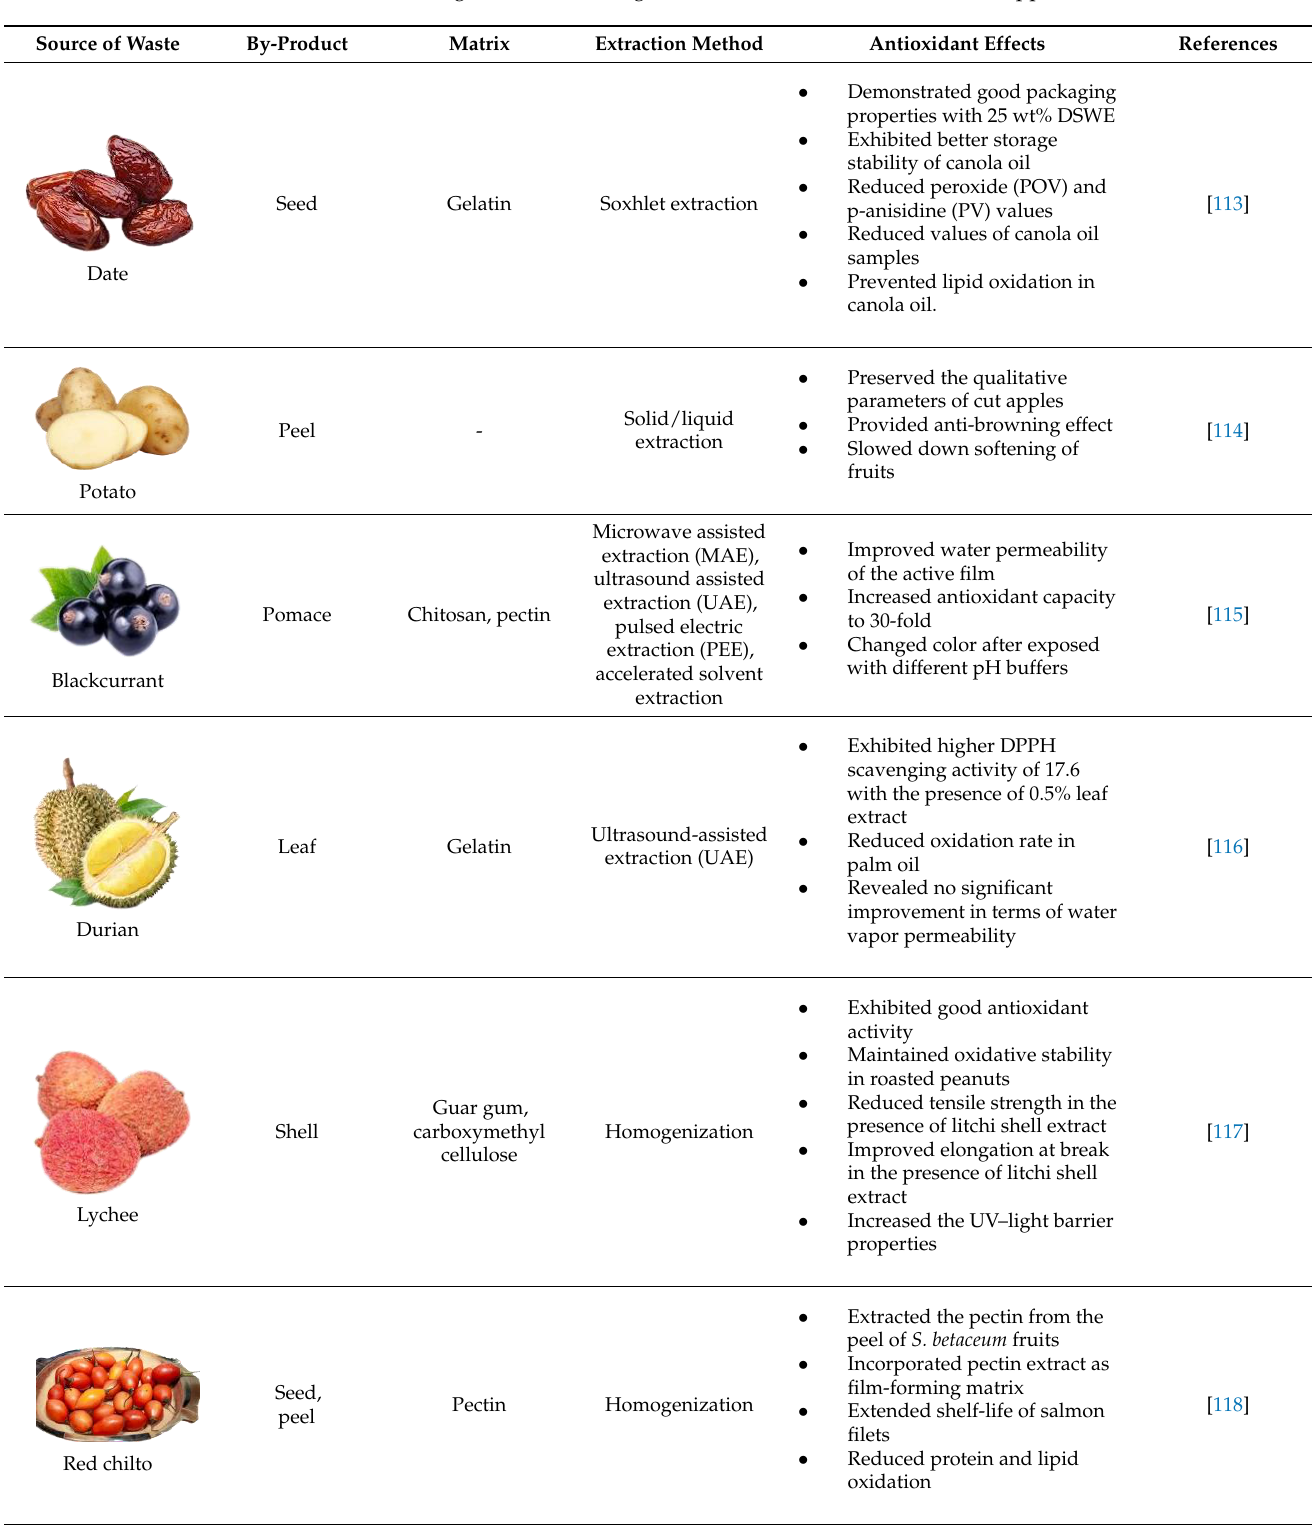
Table 2. Usage of fruits and vegetables waste as antioxidant in food applications.